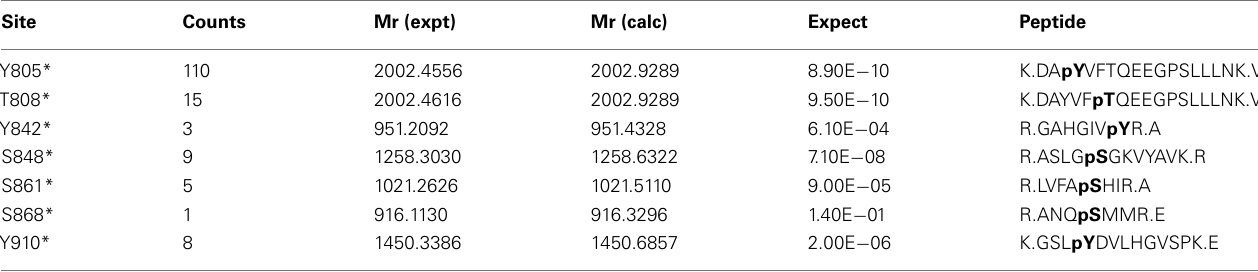
Table 3 | Identified autophosphorylation sites of Flag-PEPR1 expressed in E.coli